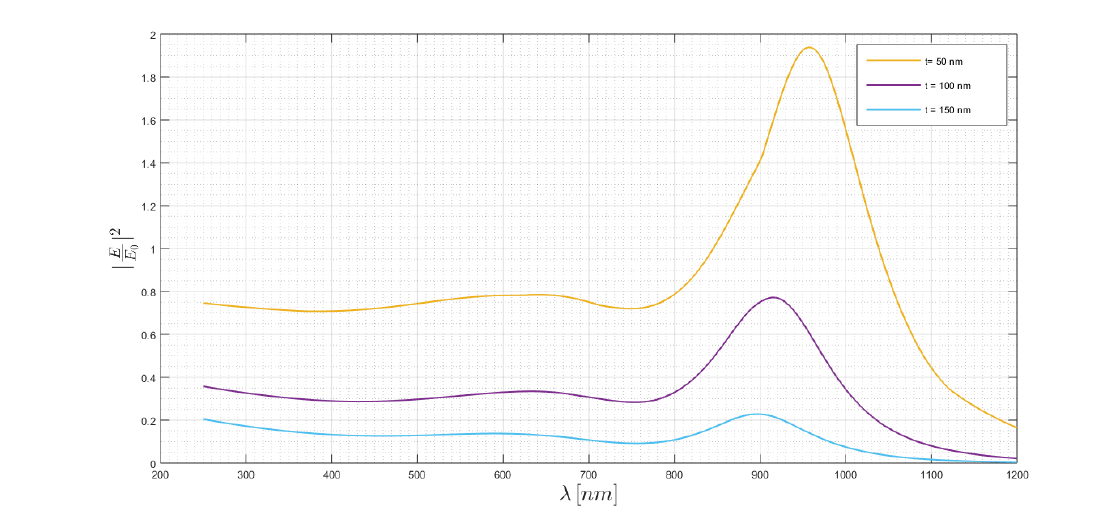
Figure 12. Nanoantenna thickness sweep on the gold nanostructure.